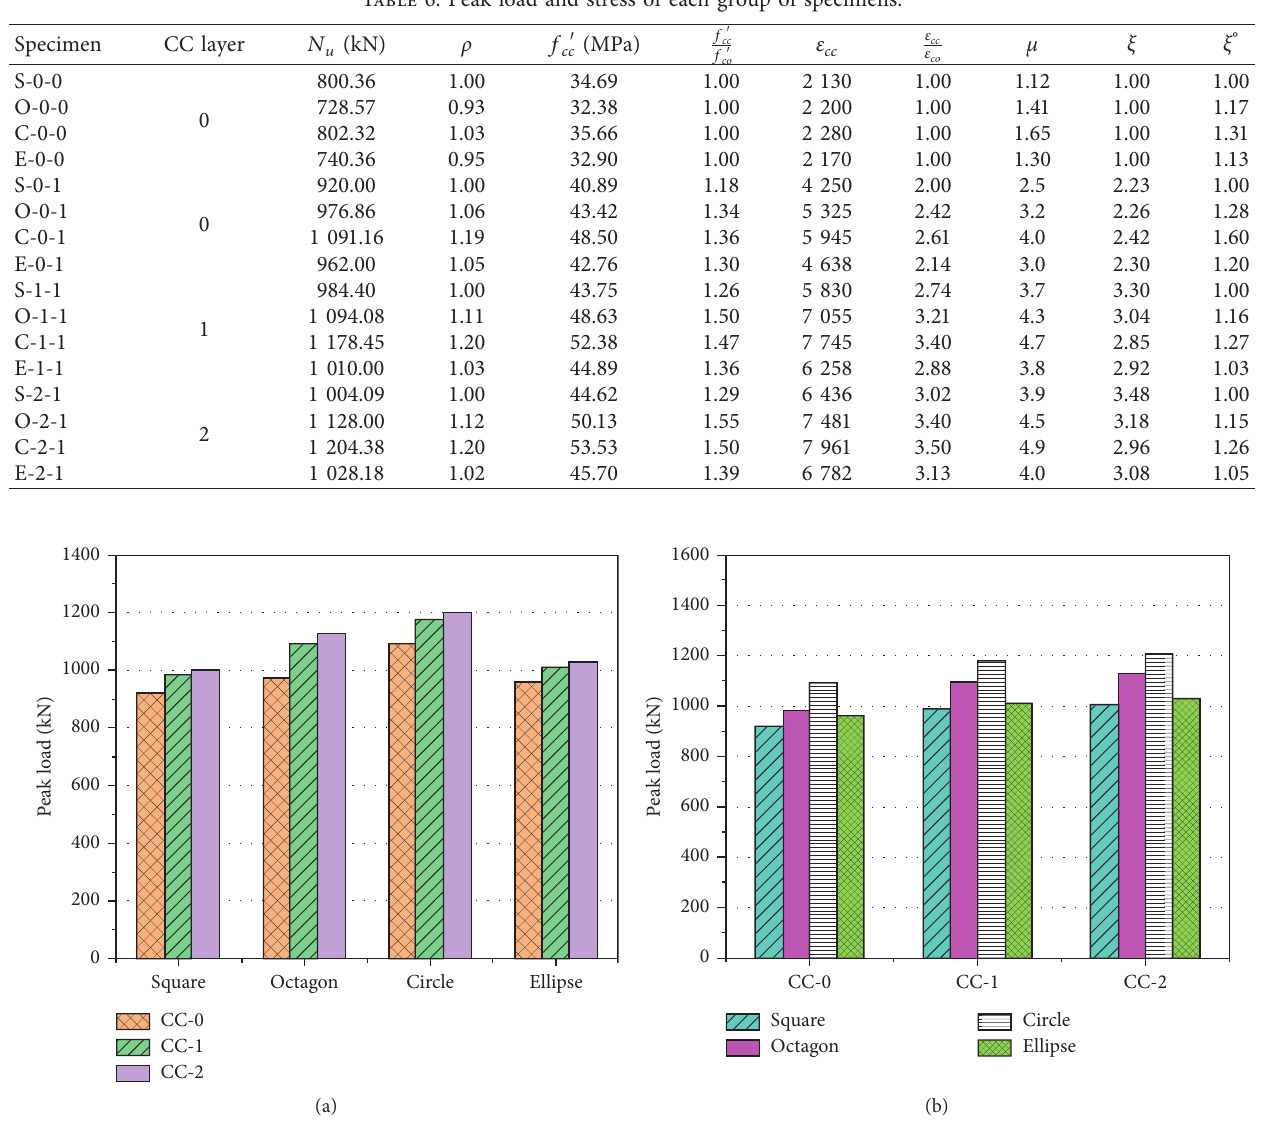
Figure 7: The peak load of the columns with different cc layers and cross-sectional shape. (a) CC layers. (b) Cross-sectional